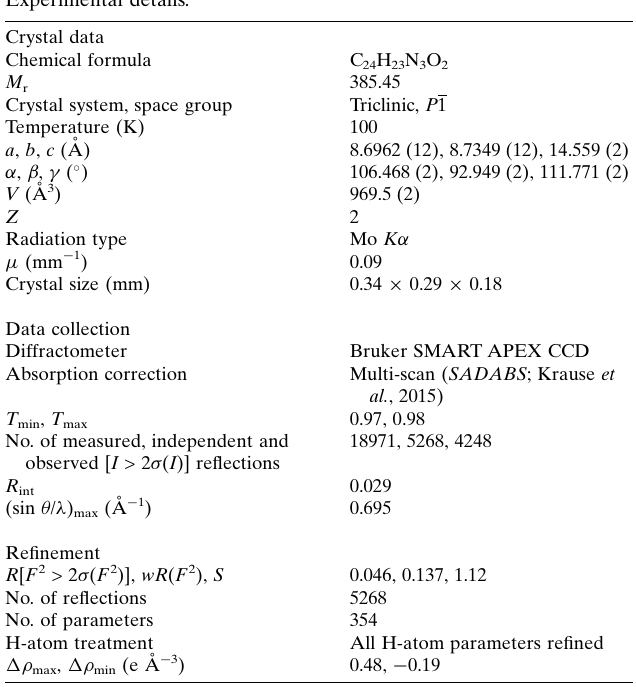
Table 2 Experimental details.